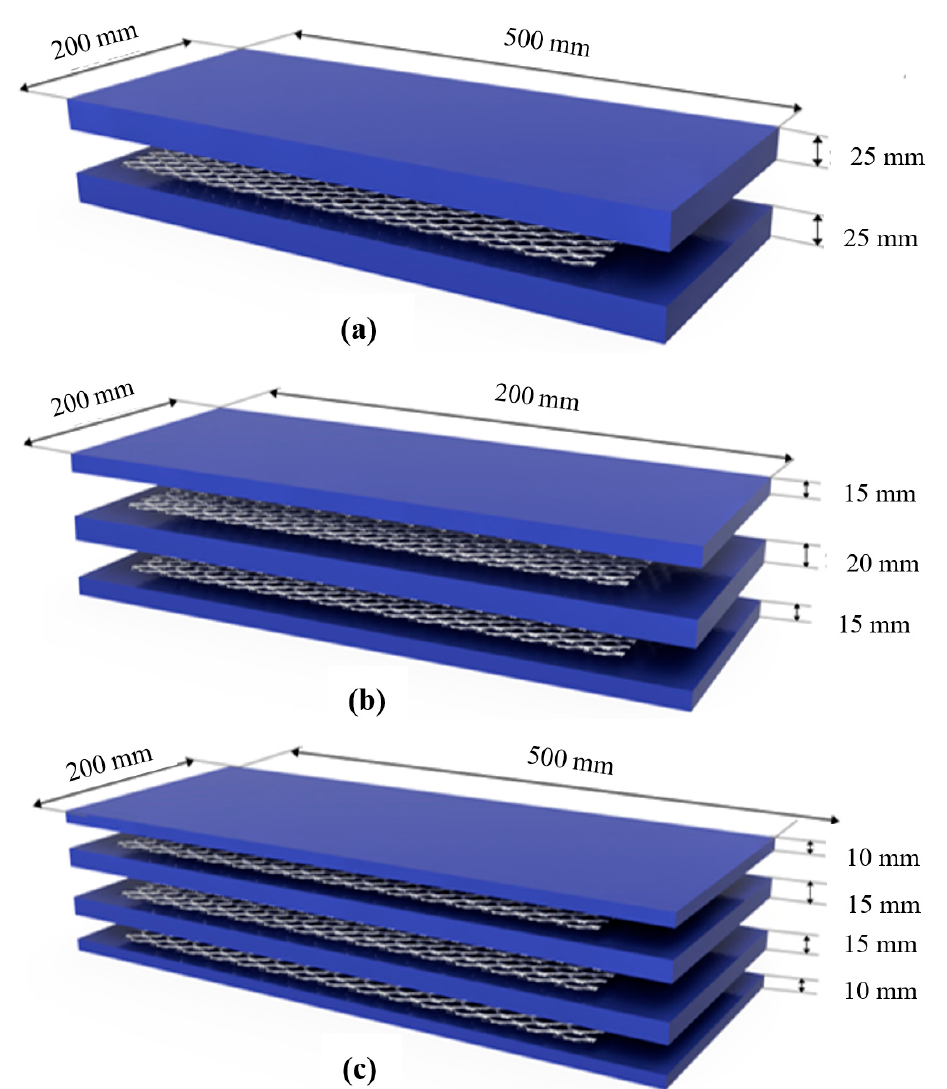
Figure 2. Details of layer thickness ( a ) single mesh; ( b ) double mesh; and ( c ) triple mesh.